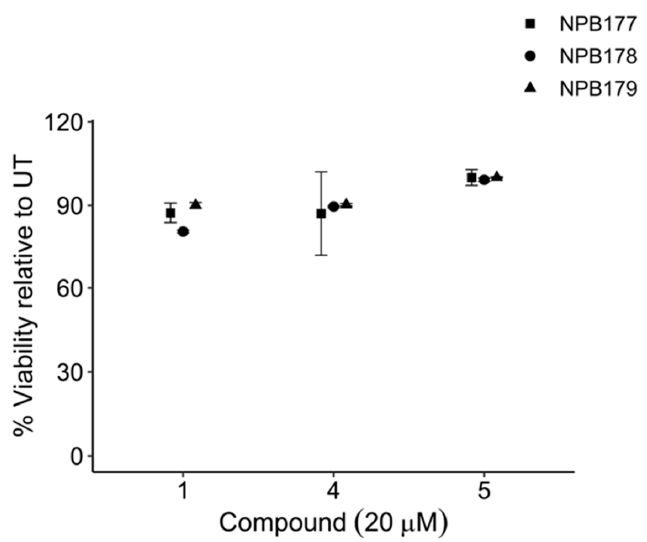
Figure 8. Viability of normal cells after treatment with compounds 1, 4, and 5 compared with untreated control cells (UT). Peripheral blood mononuclear cells (PBMCs) were isolated from the buffy coats of healthy adult volunteers (NPB 177, NPB 178, NPB 179) and treated for 48 h with 20 µM of compounds 1, 4, or 5. Cells that were negative for YO-PRO-1 iodide and 7-AAD were scored as viable. Error bars are ±SEM.